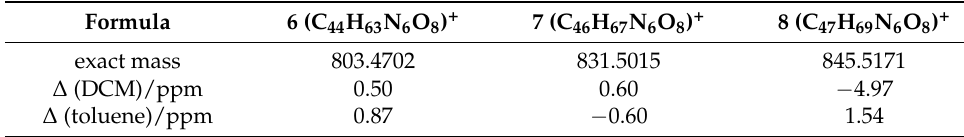
Table 1. Calculated and observed masses for the